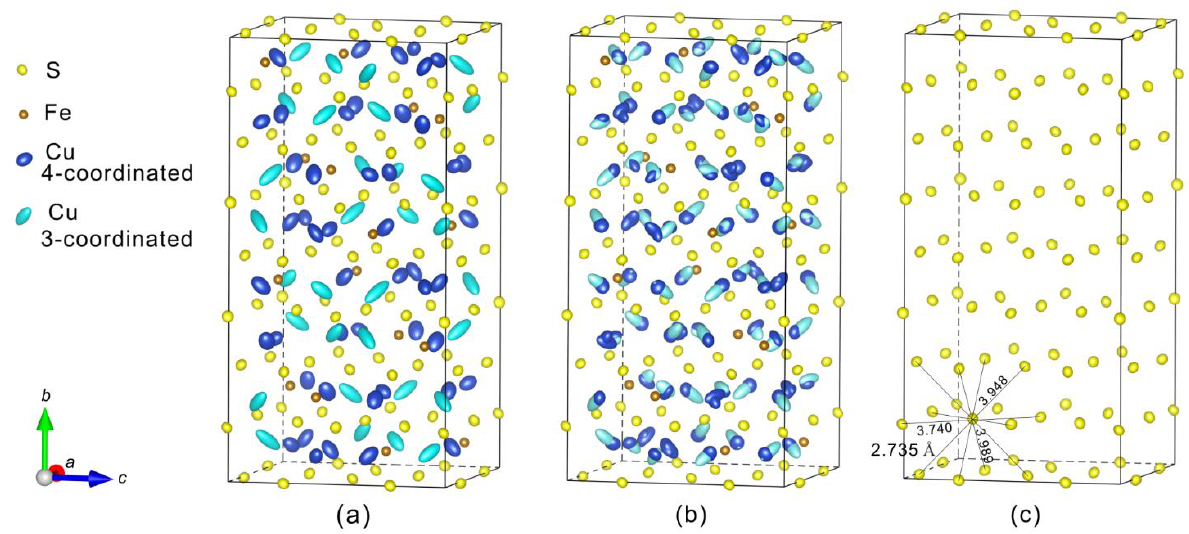
Figure 2. The crystal structure of bornite, showing the sites and the anisotropic displacement ellipsoids in the unit cell. ( a ) without site splitting of Cu atoms. ( b ) with site splitting of Cu atoms. ( c ) S layers parallel to (010) showing each S atom with its 12 closest neighbors.